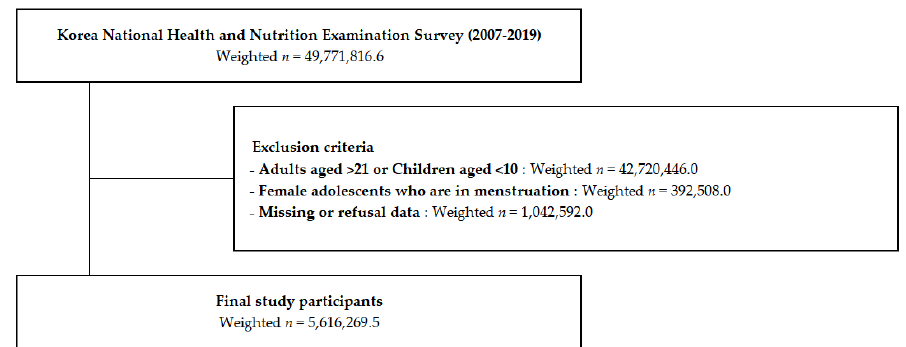
Figure 1. Schematic diagram of the participant selection process.